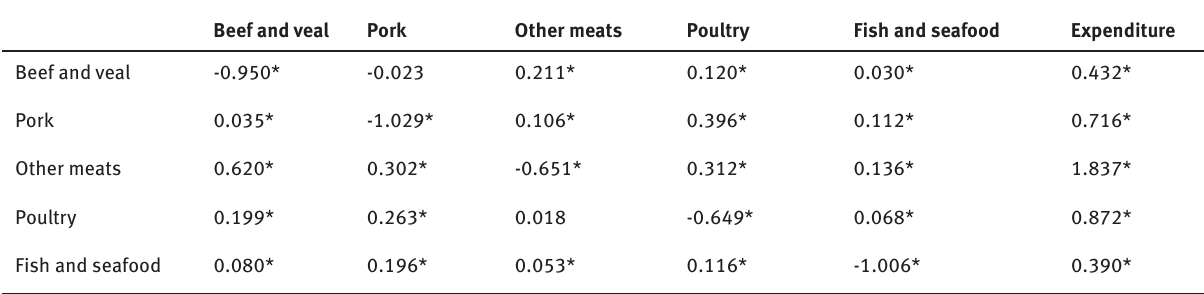
Table 6: Compensated elasticities for disaggregated model